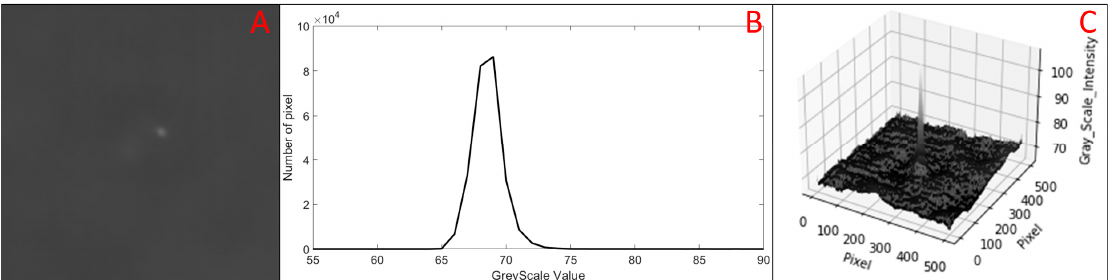
Figure 7. The first image after the end of discharge ( A ) with the corresponding grey scale value distribution of its pixels ( B ) and the grey scale histogram ( C ) utilized by the algorithm to set the binarization threshold.